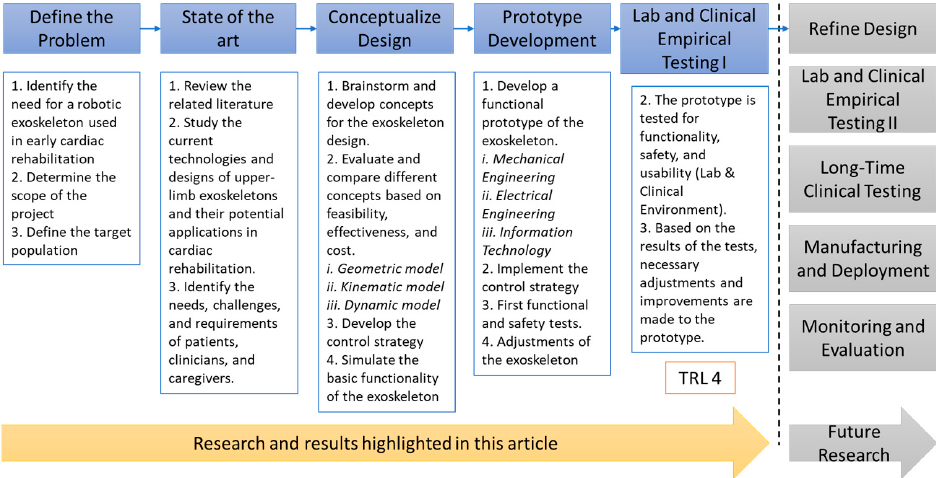
Figure 1. The design flowchart of the robotic exoskeleton and the paper methodology.